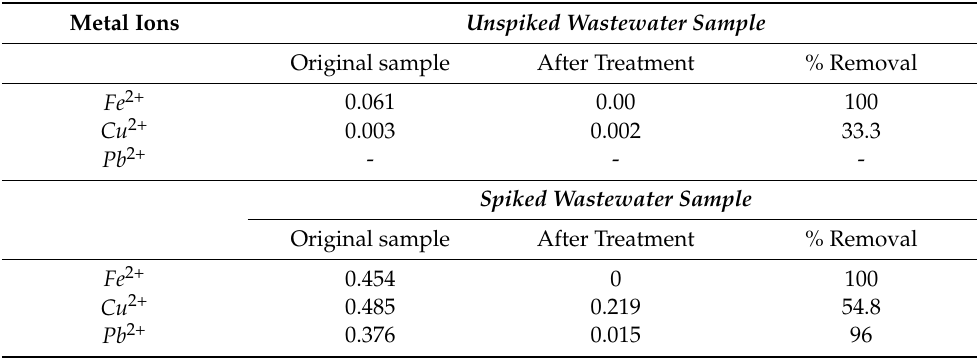
Figure 7. Molecular level adsorption of Cu 2+ , Pb 2+ , and Fe 2+ ions on MXM at the B3LYP/6-311G* and SDD levels of theory. (a) The optimized adsorption configurations of the metal ions on MXM , and the molecular level adsorption of (b) Cu 2+ , (c) Pb 2+ and (d) Fe 2+ ions at the B3LYP/6-311G* and SDD levels of theory. Table 3. Comparison of the metal ions concentrations before and after treatment of wastewater sample (unspiked and spiked) and spiked DI